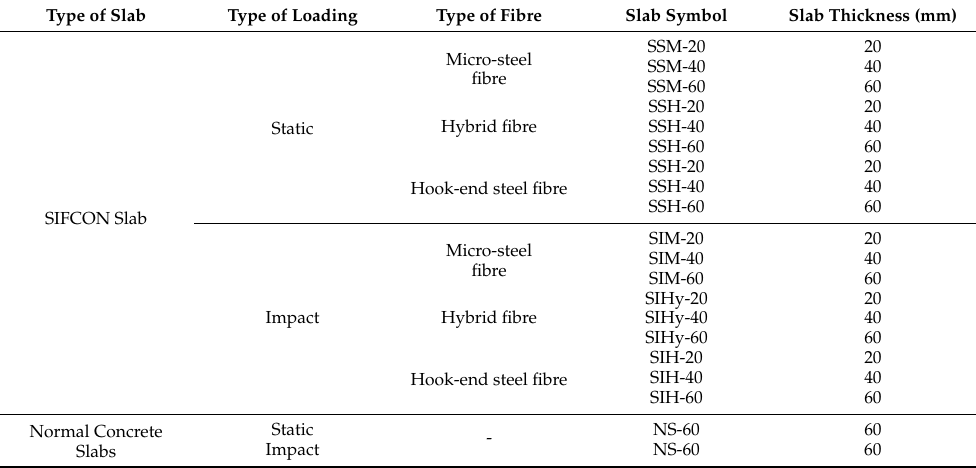
Table 2. Summary of SIFCON slab test